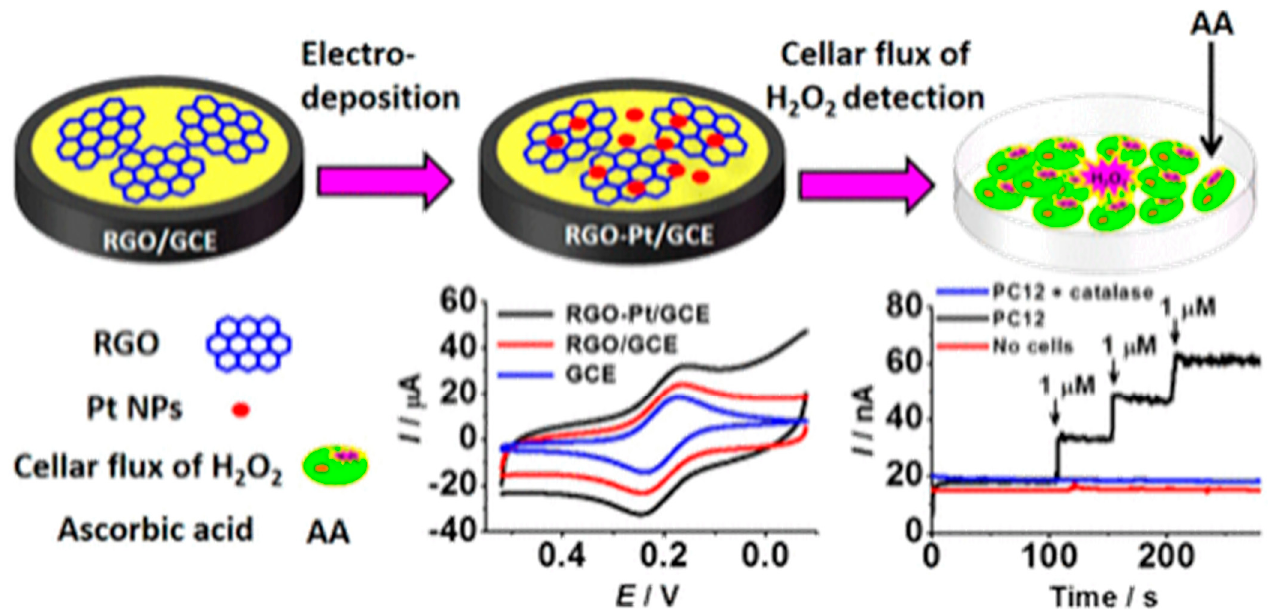
Figure 3. Schematic representation of reduced graphene oxide-platinum nanocomposite-modified glassy carbon electrode and the H 2 O 2 detection in PC-12 cell culture. Reprint with permission from [66]. Copyright (2014) American Chemical Society.